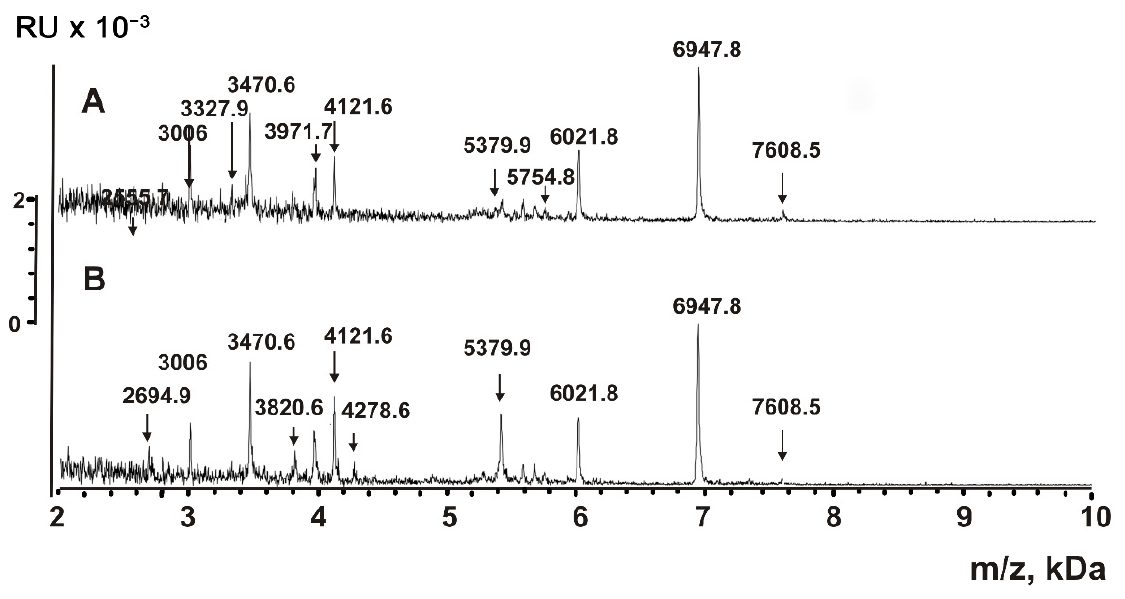
Figure 7. MALDI mass spectrometry analysis of P2 + P3 exosome extracts obtained after affinity chromatography on anti-CD9- ( A ) and anti-CD63-Sepharose ( B ). The extracts were obtained after the destruction with TFA and acetonitrile. The error in determining the m / z values did not exceed 0.5–1.0 Da.